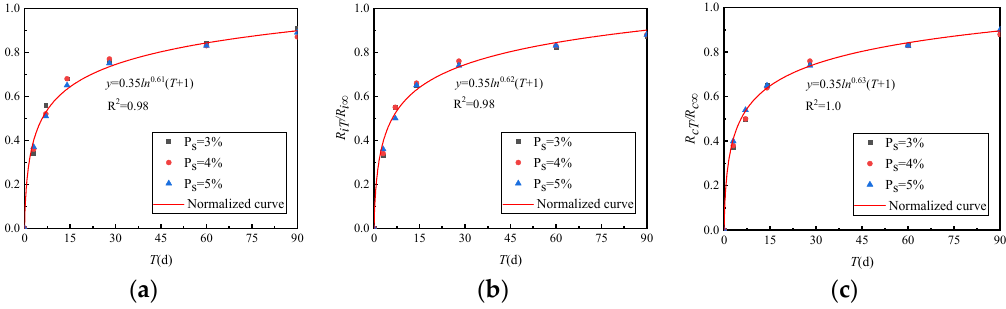
Figure 15. Growth law of R iT / R i ∞ between general grading and VGM-30. ( a ) GF1, ( b ) GF2, ( c ) VGM-30.